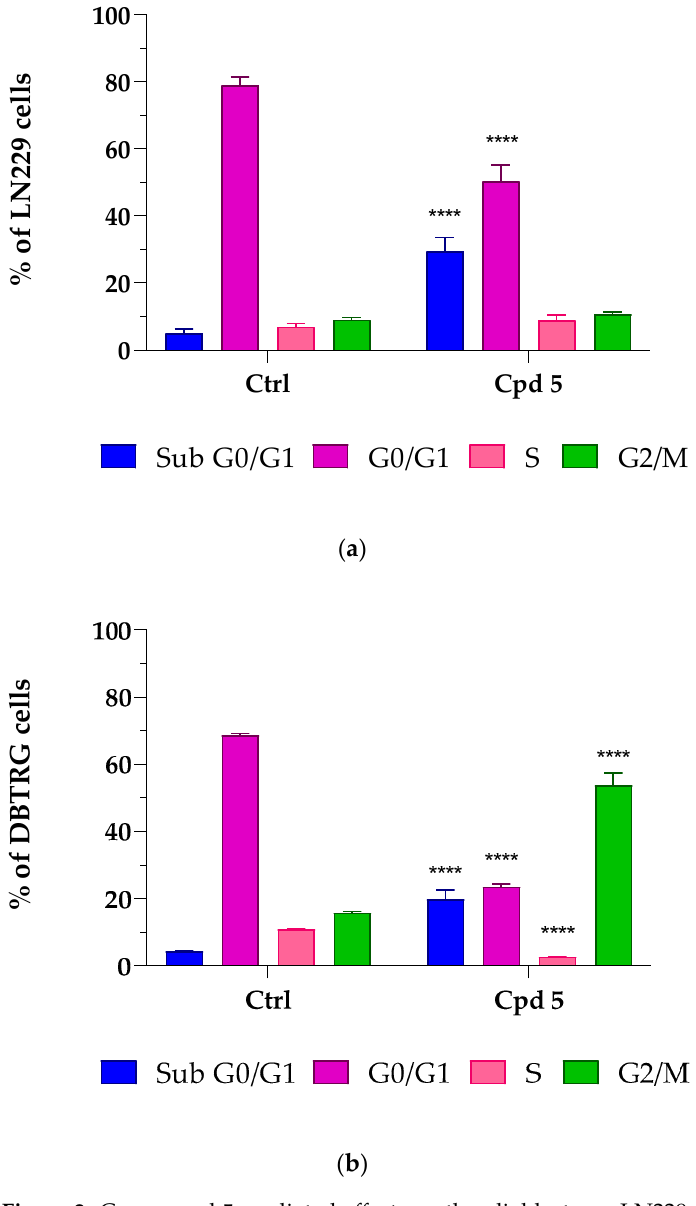
Figure 2. Compound 5 -mediated effects on the glioblastoma LN229 ( a ) and DBTRG ( b ) cell cycle. Cells were treated for 72 h at the compound 5 IC 50 concentrations, i.e., 6.9 µ M for LN229 and 8.5 µ M for DBTRG. Percentages of cells in sub G0/G1 (Blue), G0/G1 (Purple), S (Pink), and G2/M (Green) phases are reported as the means ± SD of at least three independent experiments run in